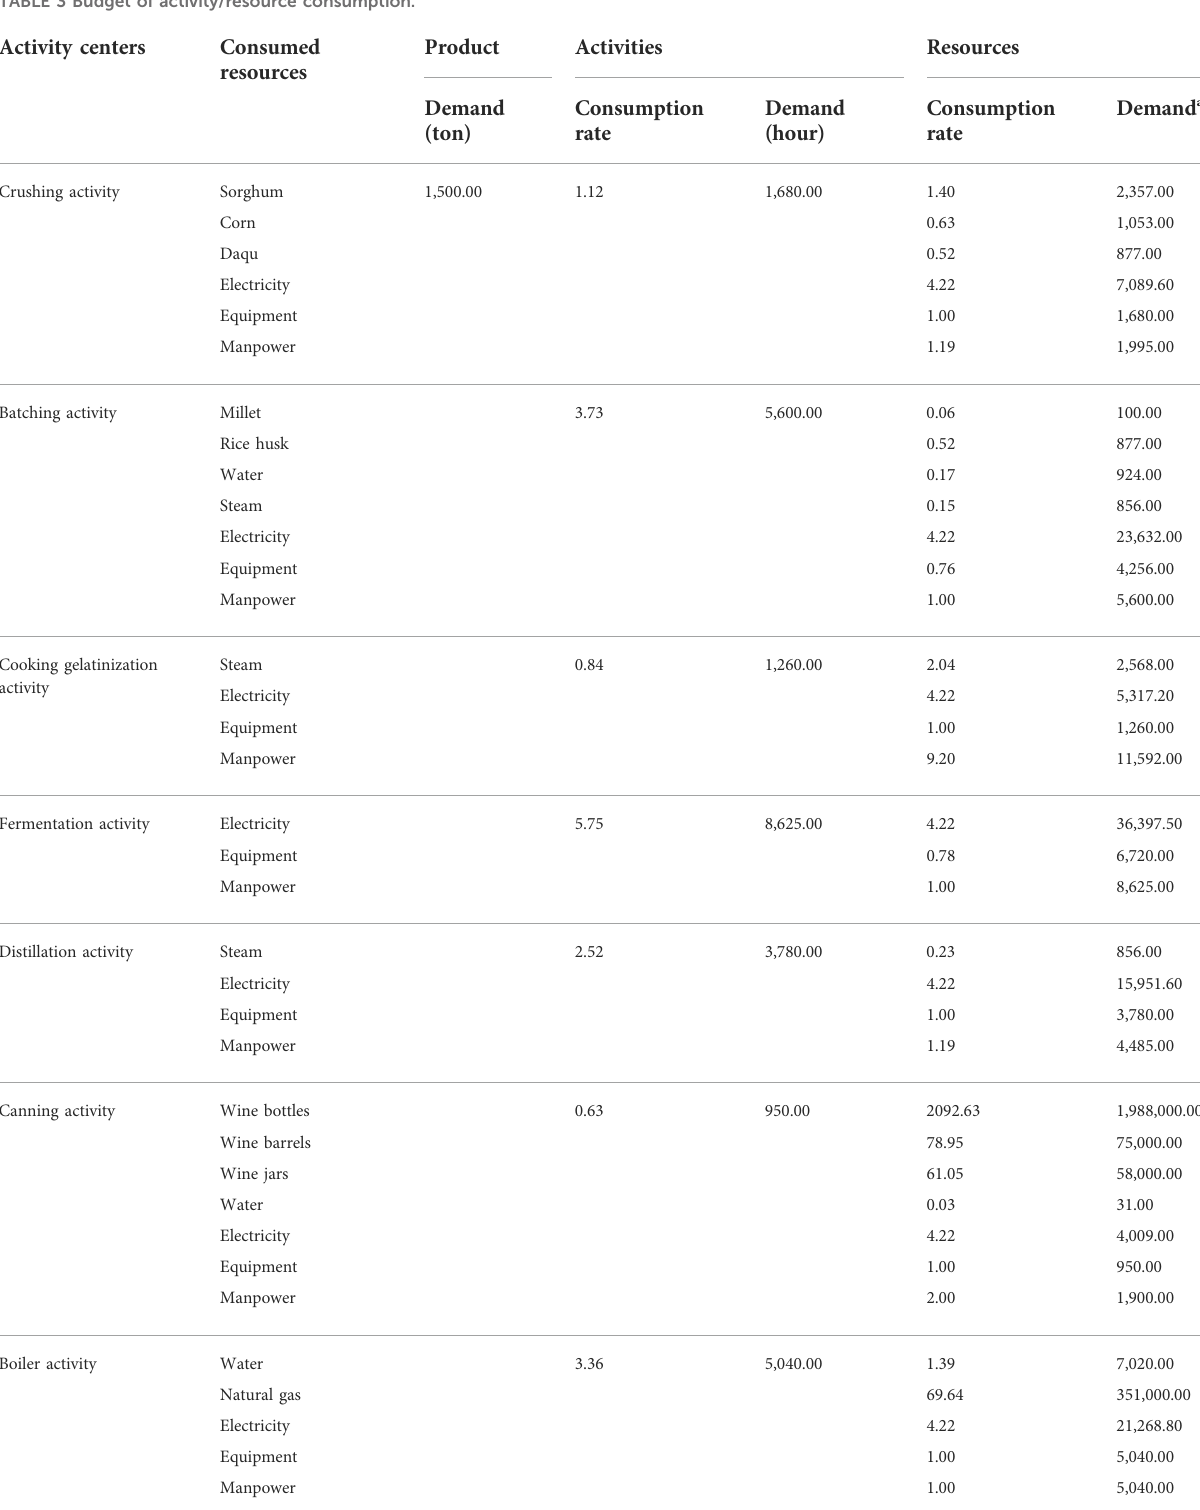
TABLE 3 Budget of activity/resource